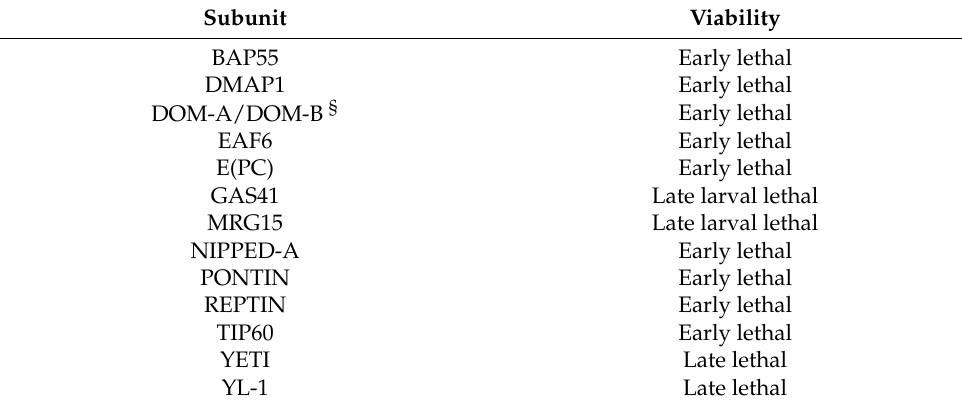
Table 1. Silencing of genes coding for Tip60 complex subunits arrests fly development. About 100 flies were scored for each cross. § Simultaneous